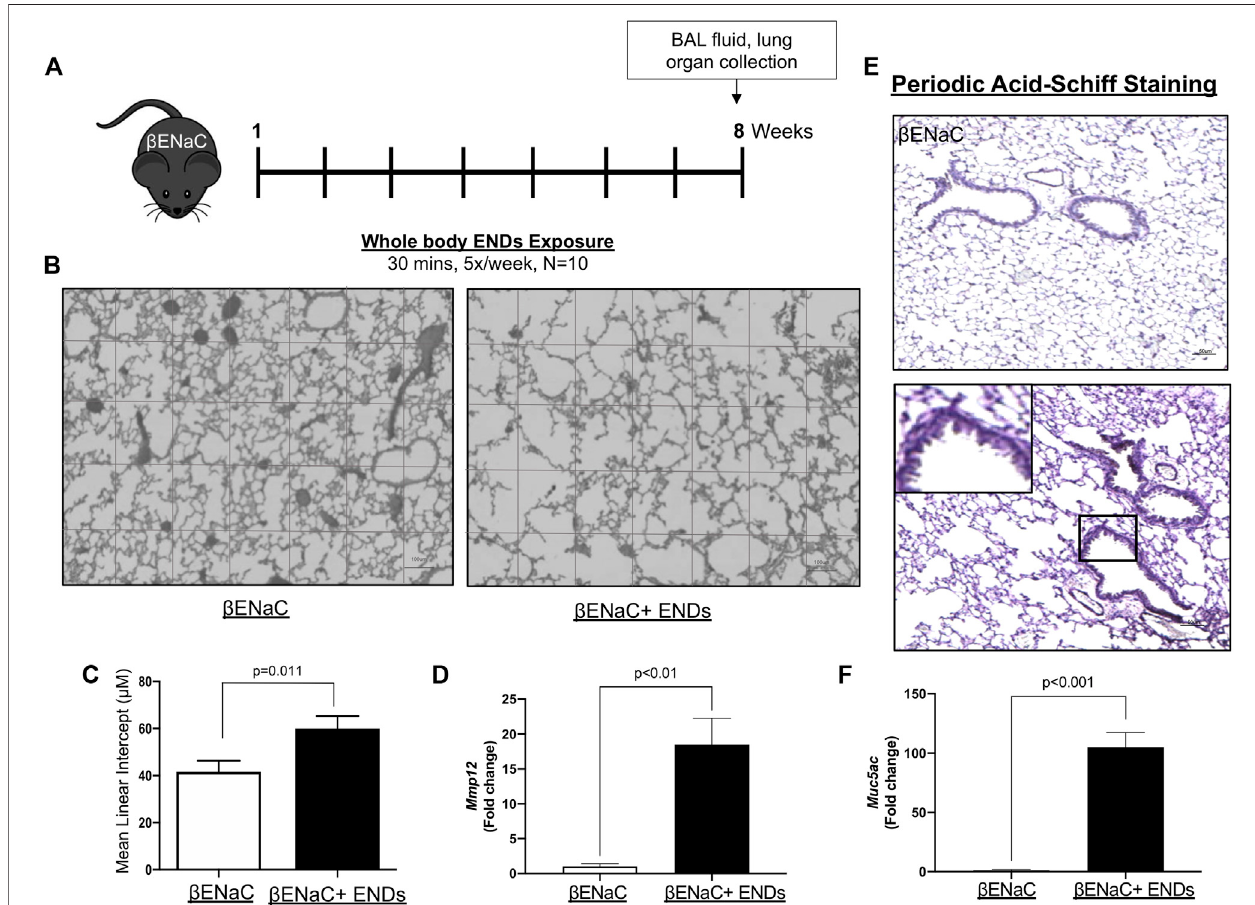
FIGURE 1 | E-cigarette exposure aggravates COPD in β ENaC mice. (A) Experimental schematic of whole body ENDS exposure in β ENaC mice. (B) ENDS exposurecausedemphysematousphenotypeschangesin β ENaCmice.RepresentativedataofH&Estainingimagesusinglungsectionsofshamair(left)( n (cid:1) 4)orENDS exposed (right) ( n (cid:1) 4) mice. (C) Quanti fi cation of the free distance between gas exchange surfaces in lungs of β ENaC mice with or without ENDS exposure. (D,F) DeterminationofmRNAlevelsofCOPD-relatedproteinsMMP12 (D) andMuc5ac (F) inlungtissuesfrom β ENaCmicewithorwithoutENDSexposurebyqPCR. (E) Representative images of Periodic Acid-Schiff staining in lung sections of β ENaC mice with or without ENDS exposure. The inset indicates the enlarged image of the boxed area showing positive staining. All data presented at mean ± SEM.